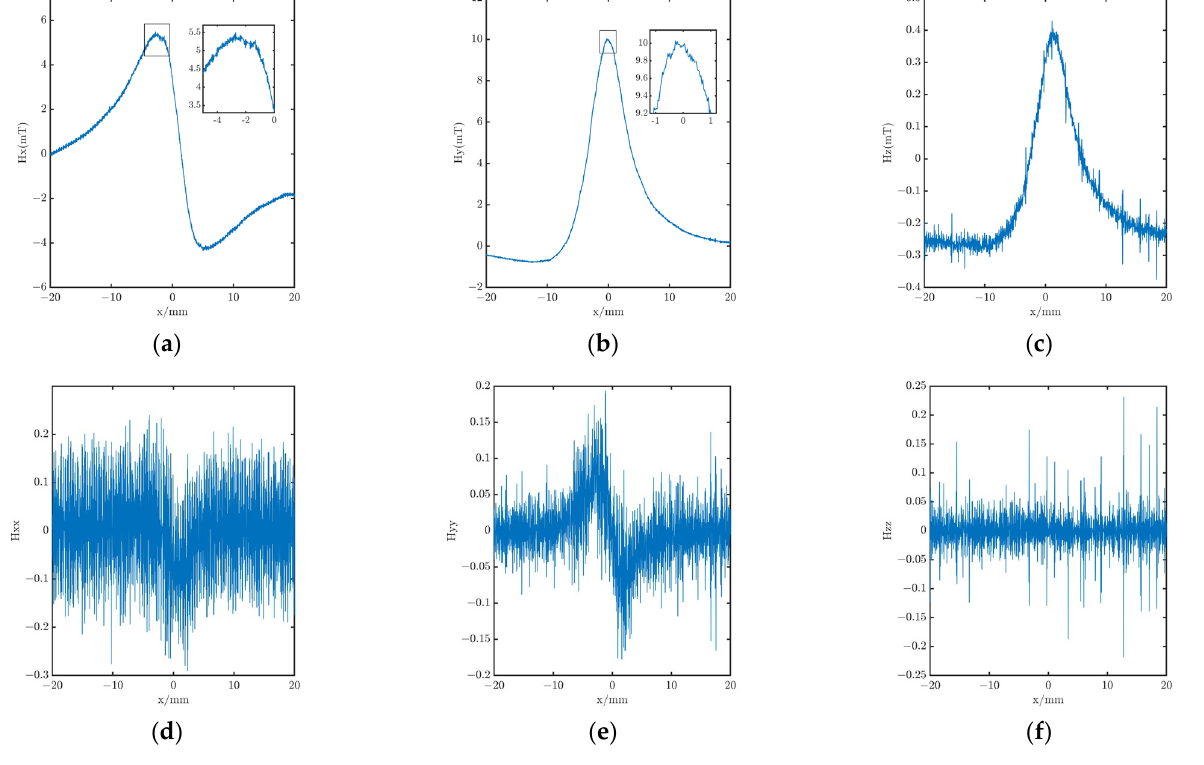
Figure 3. Enhanced metal magnetic memory testing signal and magnetic gradient signal. ( a ) Normal component signal. ( b ) Tangential component signal. ( c ) Horizontal component signal. ( d ) Gradient value of the normal component signal. ( e ) Gradient value of the tangential component signal. ( f ) Gradient value of the horizontal component signal.